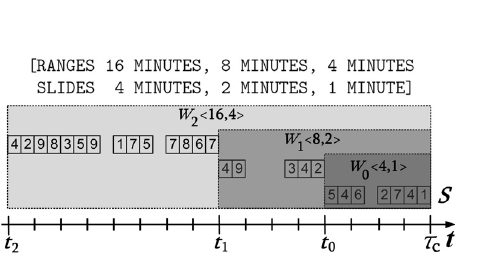
Figure 1: A 3-level sliding window. Figure 2: Stairwise processing scheme